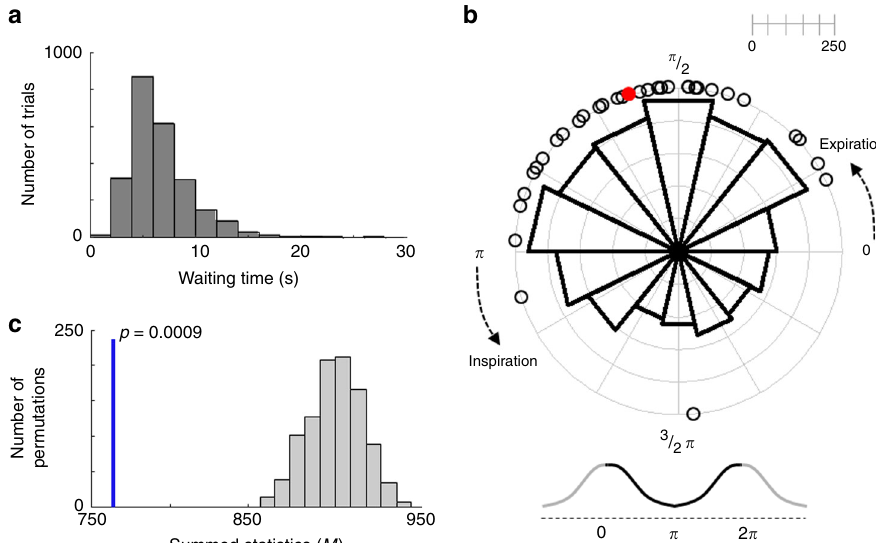
Fig. 2 Coupling between voluntary action and respiratory phase during the Libet task in Experiment 2. a Distribution of waiting times (pooled across 32 participants) showed the typical rightward skewed shape. b Distribution of respiration phases with respect to the timing of voluntary action onset. Empty black circles represent each participant ’ s mean respiration phase at button press. Participants initiated voluntary actions more frequently during the expiration phase. The polar histogram shows the distribution of all the button presses from 32 participants, which was also concentrated in the expiration phase. The red dot indicates the grand-averaged respiration phase at button press. c The computed test statistics using original data (indicated by the blue vertical line) was signi fi cantly smaller than chance-level statistics obtained from phase shifted surrogate respiration data (indicated by the histogram; permutation p = 0.0009), showing the timing of button presses in Experiment 2 is coupled with respiration phase.